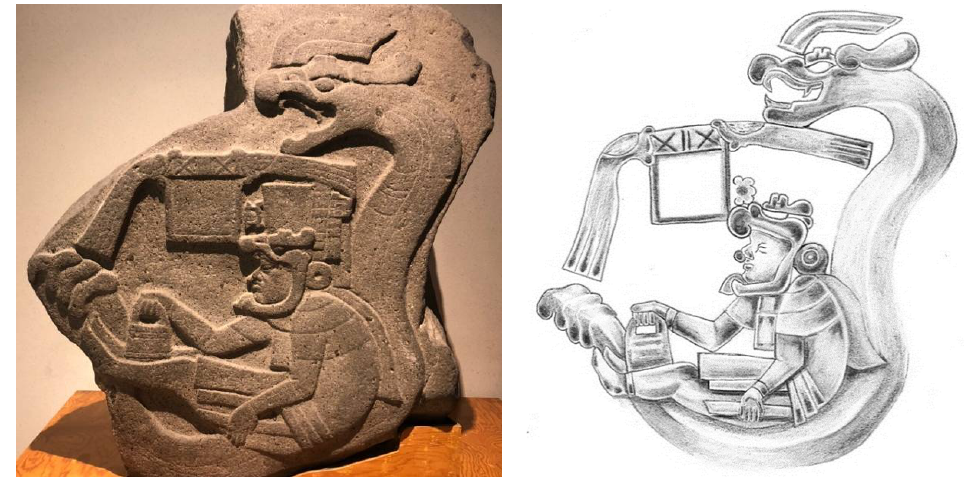
Figure 3. Left —The feathered serpent and Quetzalcoatl as seen on LVM-19. Photo taken by 1st author at the National Museum of Anthropology, Mexico City, Mexico. Right —Rendition of Quetzalcoatl and the feathered serpent. Take notice of the name glyph made up of two Xs and two birds. Taube (1995) believes this stands for an early writing script associated with avian serpents. Abstract Xs and birds we also see them on pottery of the same period. Drawing by 2nd author.